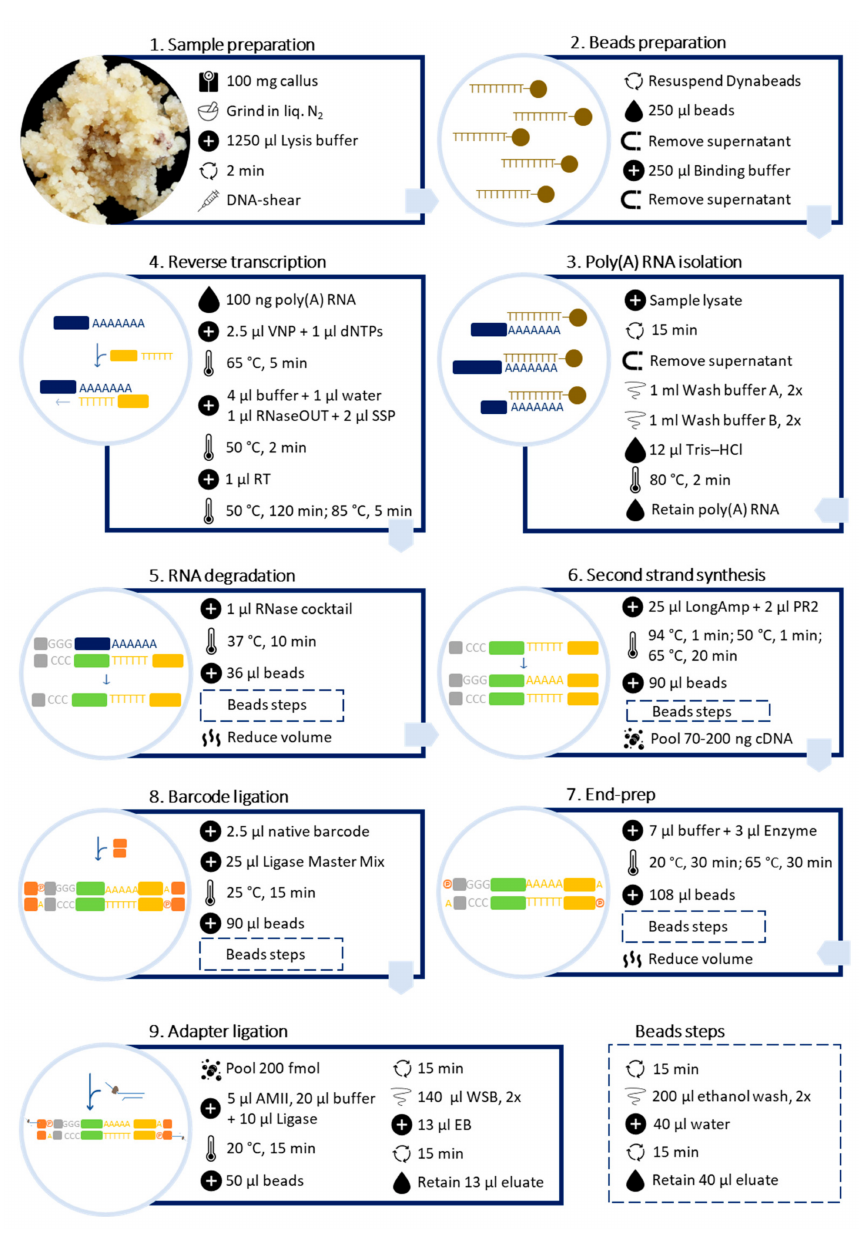
Figure 2. Schematic workflow for preparing barcoded cDNA libraries from plant callus for long-read sequencing, using Dynabeads™ mRNA DIRECT™ Kit (Invitrogen™) and Direct cDNA Sequenc- ing Kit (ONT, Cat. No. SQK-DCS109) with Native Barcoding Expansion 1–12 (ONT, Cat. No.